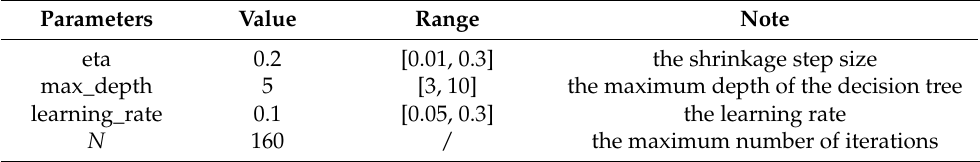
Table 2. Parameters of XGBoost Model. Parameters